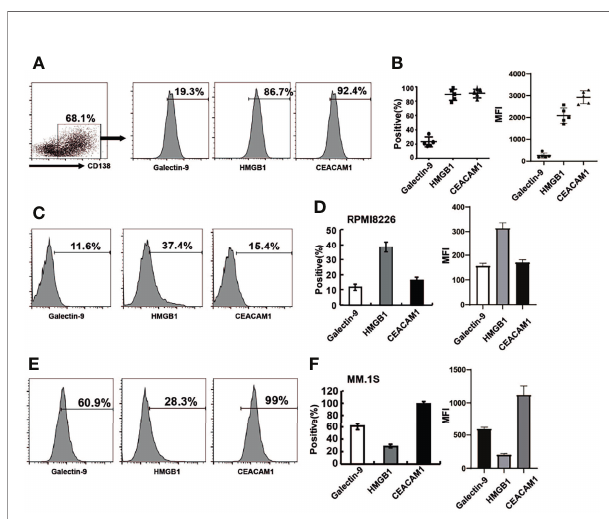
FIGURE 2 | The expression of Tim-3 ligands in primary MM cells and MM cell lines. Tim-3 ligands expression were quanti fi ed by fl ow cytometry. (A) CD138 + MM cells were sorted by immunomagnetic separation from the bone marrow of MM patients and stained with Galetin-9, HMGB1, CEACAM1 for the proportion of Tim-3 ligands + MM cells. (B) Statistical analysis of the proportion and MFI of Tim-3 ligands + MM cells (n=5). (C, D) The expression of Tim-3 ligands in MM cell line RPMI8226 cells. (E, F) The expression of Tim-3 ligands in MM cell line MM.1S cells. Representative results from one of at least three independent experiments were exhibited. Data shown were mean ± SD of at least three independent